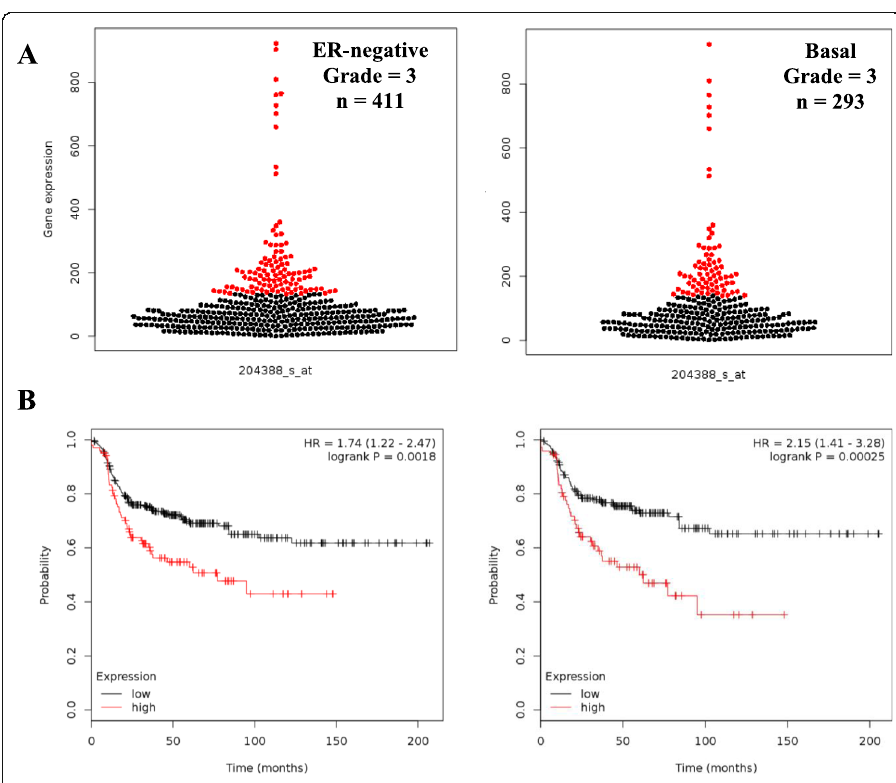
Fig. 3 MAO-A expression predicts recurrence-free survival in patients who experienced ER − or TNBC tumors. a Beeswarm plot showing MAO-A expression in 411 grade 3 ER − tumors and 293 grade 3 basal-like tumors; red dots show upper quartile separation range. b Kaplan-Meier survival curves comparing RFS for high- and low-expressing tumors in ER − [HR = 1.74 (1.22 – 2.47); p = 1.8E-03] and basal-like [HR = 2.15 (1.41 – 3.28); p = 2.5E-04] cohorts. Analyses were performed using the Km Plotter for Breast